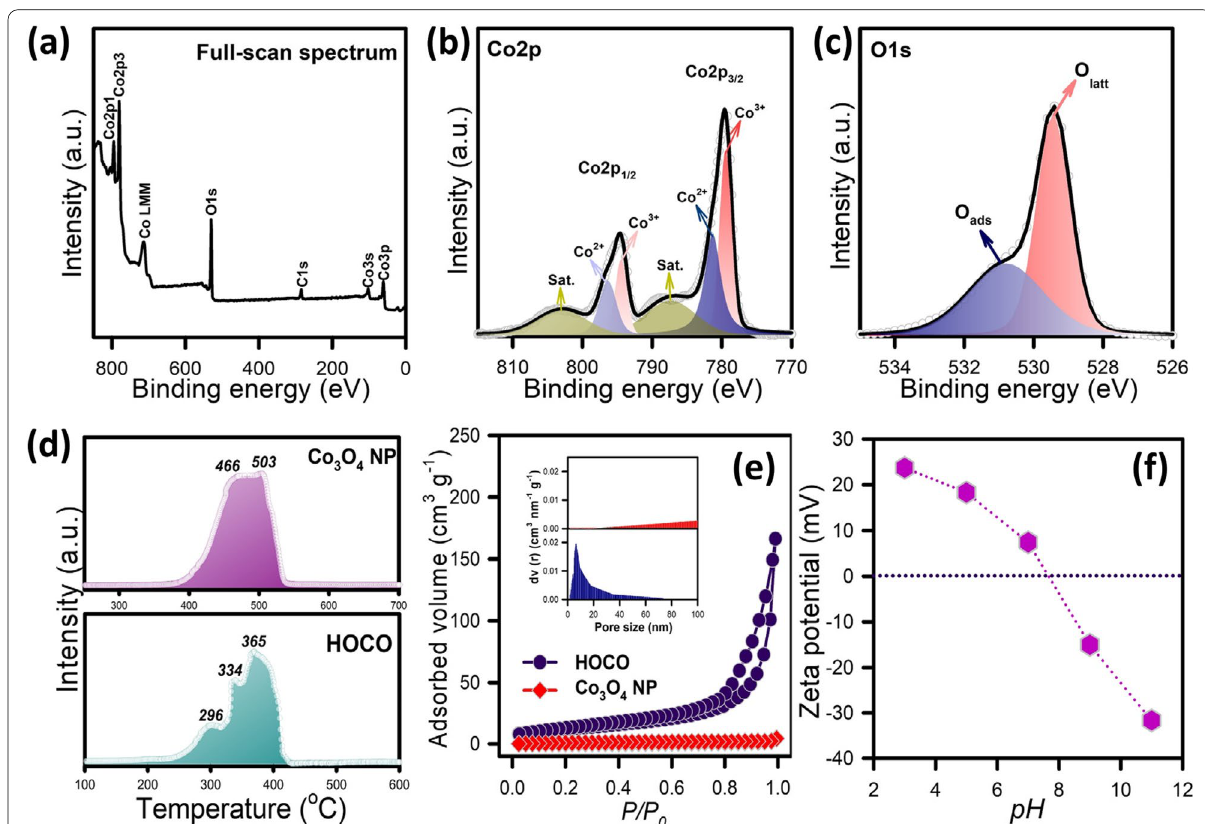
Fig. 3 XPS analysis of HOCO: ( a ) whole‑range scan, ( b ) Co2p scan, and ( c ) O1s scan; ( d ) TPR analyses of Co 3 O 4 NP and HOCO; ( e ) physical properties of Co 3 O 4 NP and HOCO; and ( f ) zeta potential of HOCO at different pH